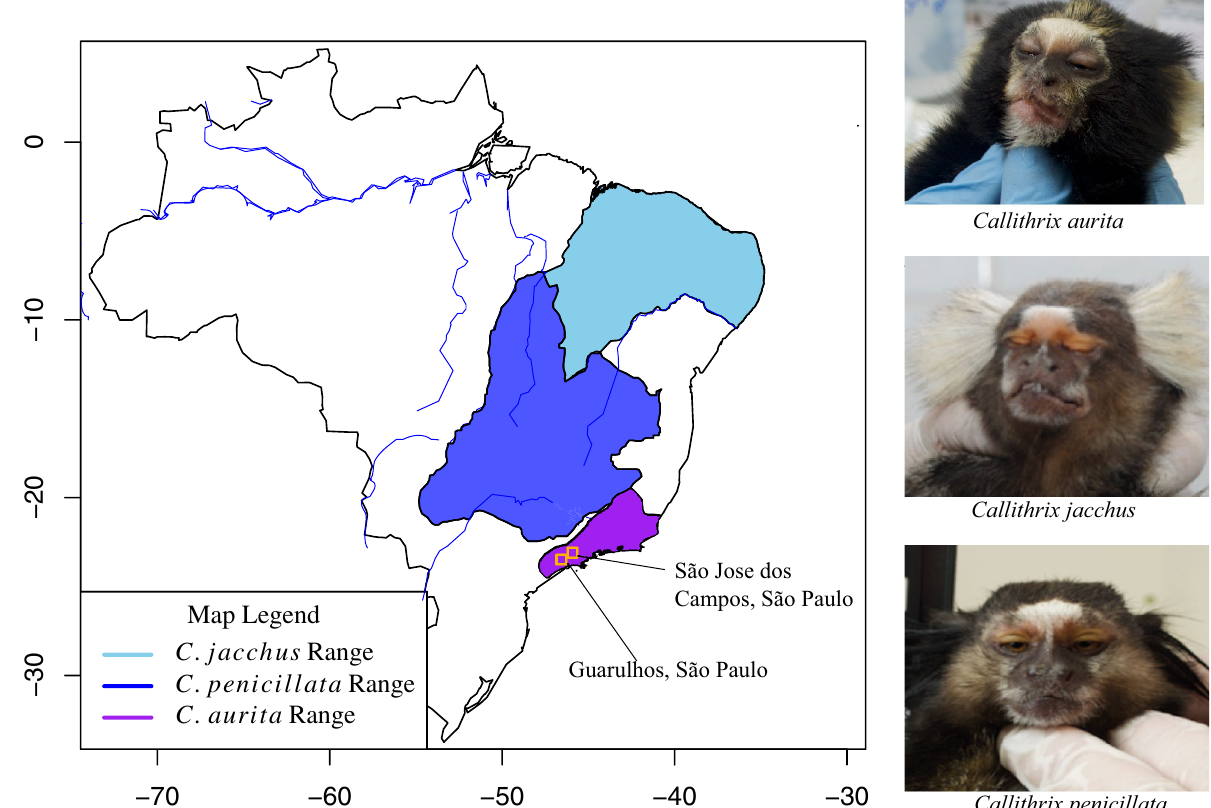
Figure 1. The distinct natural distributions and phenotypes of C. jacchus , C. penicillata , and C. aurita . Cities of origin (São Jose dos Campos) and collection (Guarulhos) of individual BJT022 are shown as orange